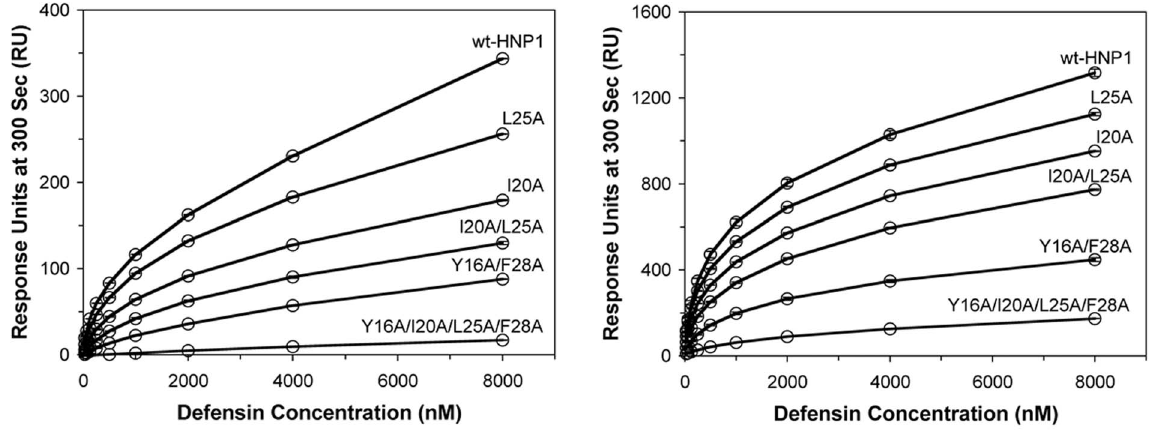
Figure 7. Surface plasmon resonance binding curves. Binding of HNP1 and mutants to 233 RU of HNP1 (left) and binding of HNP1 and mutants to 2770 RU of gp120 (right). The curves are plots of RU values at 300 s of association versus different defensin concentrations (from 0 nm to 8 m m). The RU values are the average readings from three measurements.